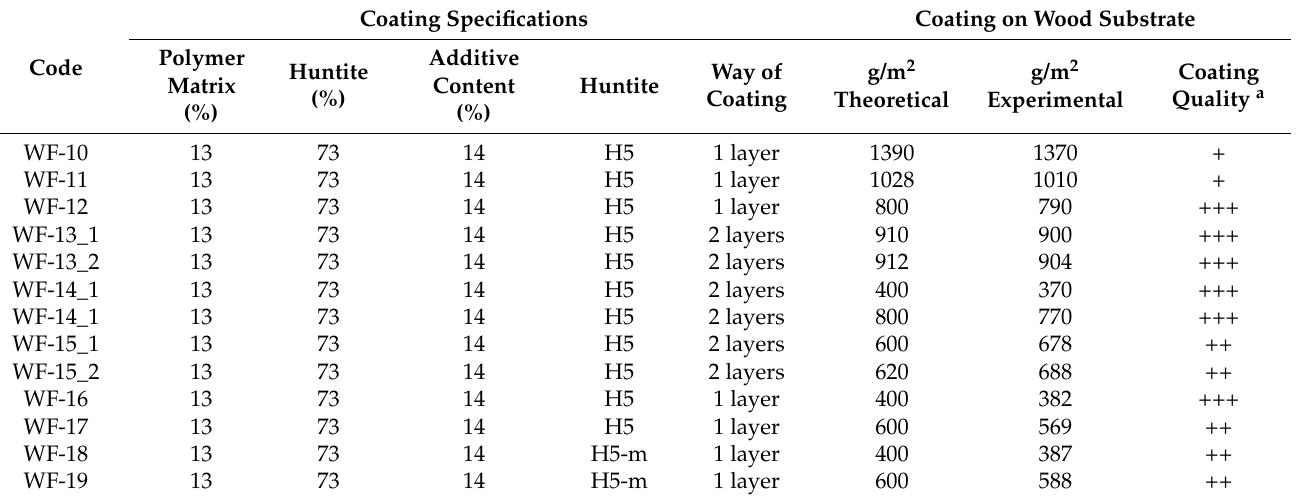
Figure 3. Cryofracture surfaces of SEM observation for Vilacryl DS55K/H5/P (SSNa-co-GMA20) coating, WF-7 ( A1 , A2 ), and Vilacryl DS55K/H5/PSSNa coating, WF-4 ( B ). Table 2. Characteristics of the coating formulations applied on wood